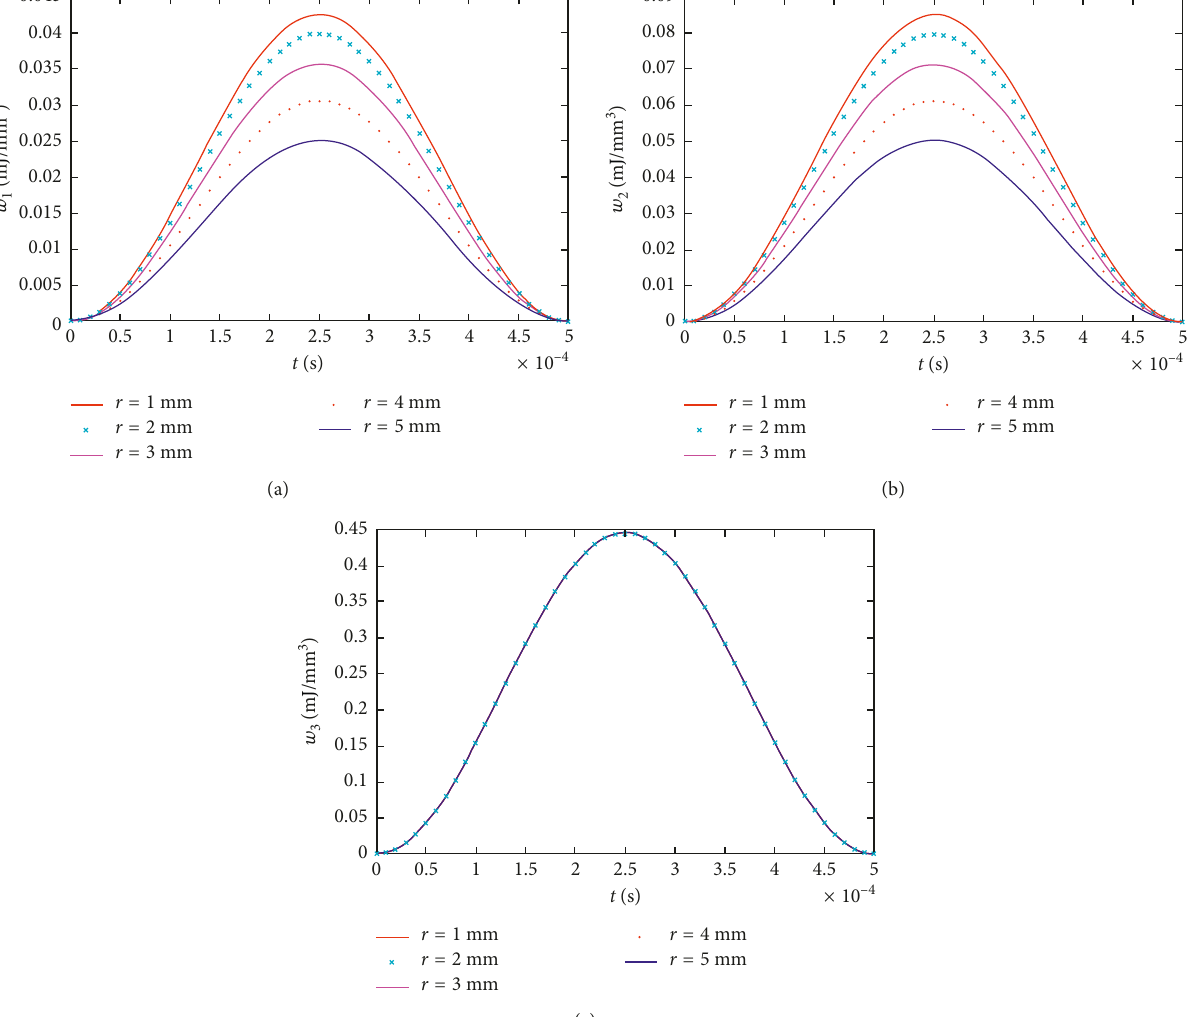
π /2, β 0). (a) The energy density caused by the flexural wave (cid:31) (cid:31)